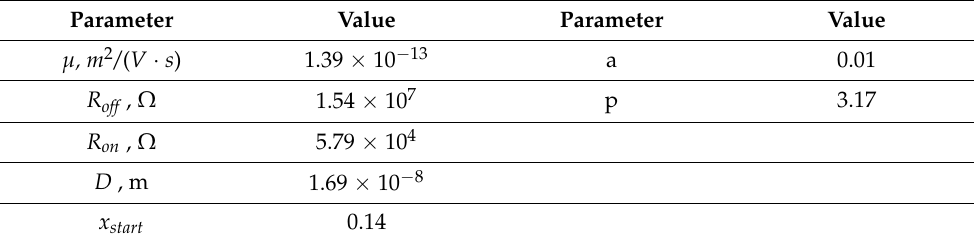
Table 10. Optimal values of parameters of the nonlinear drift model with Shi window function, obtained by approximation of the experimental loop.